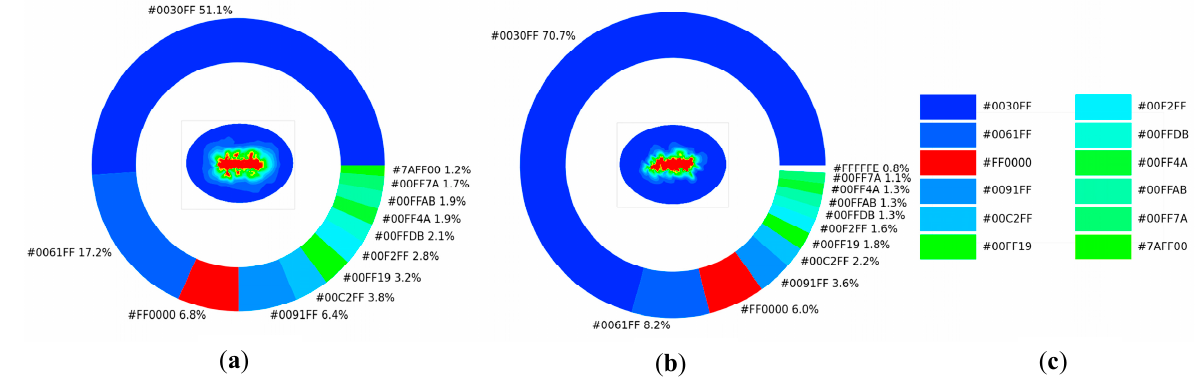
Figure 10. Digitization of velocity distribution on Plane 4: ( a ) Digitization of velocity distribution for SA; ( b ) Digitization of velocity distribution for DA; ( c ) Color codes.